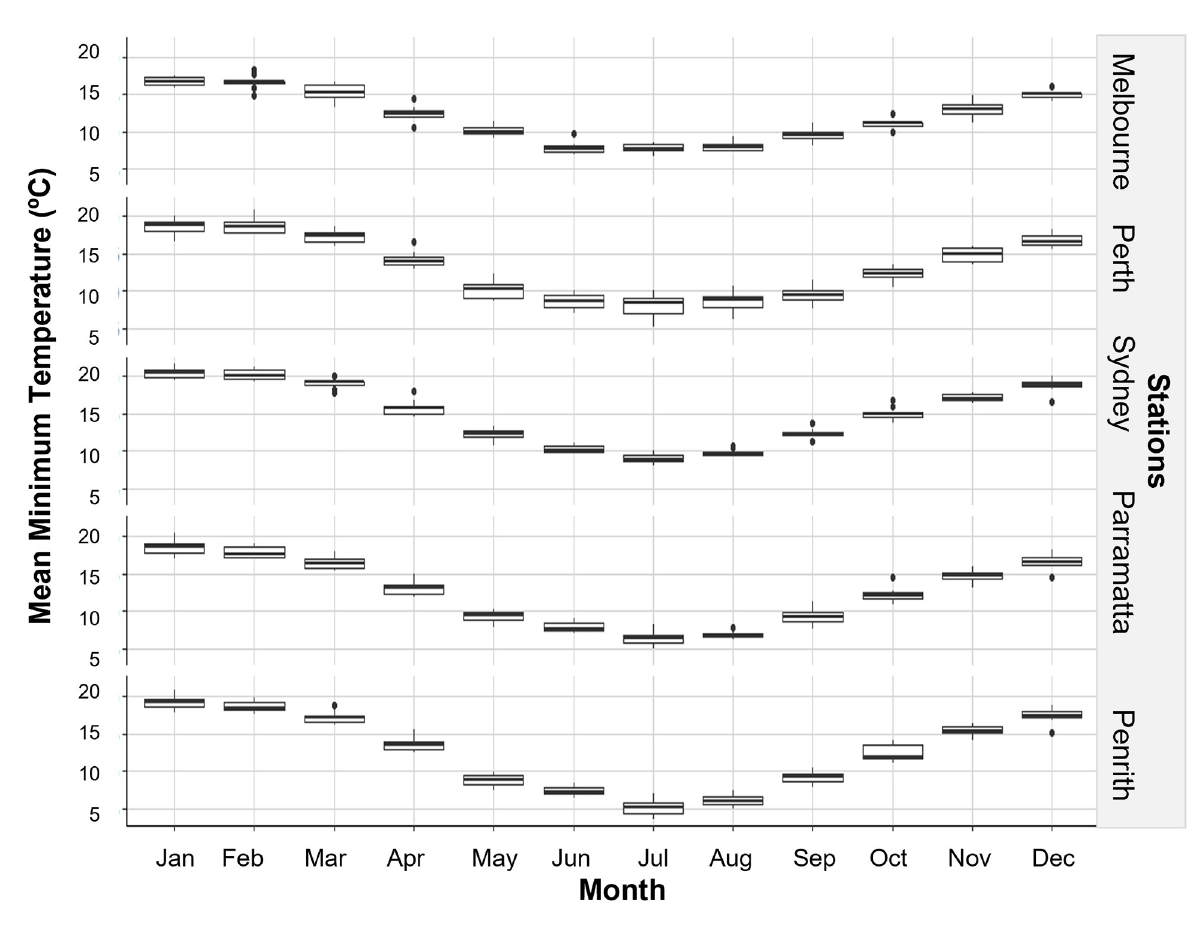
Fig 6. Trend in mean monthly minimum temperature from 2009 to 2019 at sampling